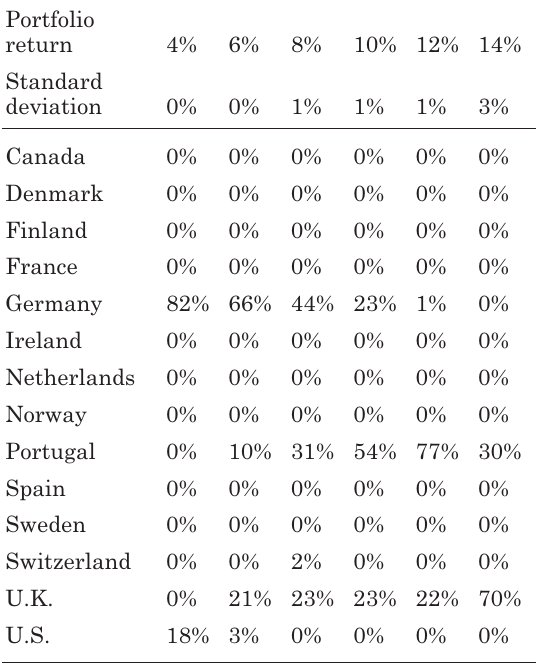
Table 5 contains the country allocations in Table 5. Asset allocation in effi cient international real estate portfolios (hedged returns)